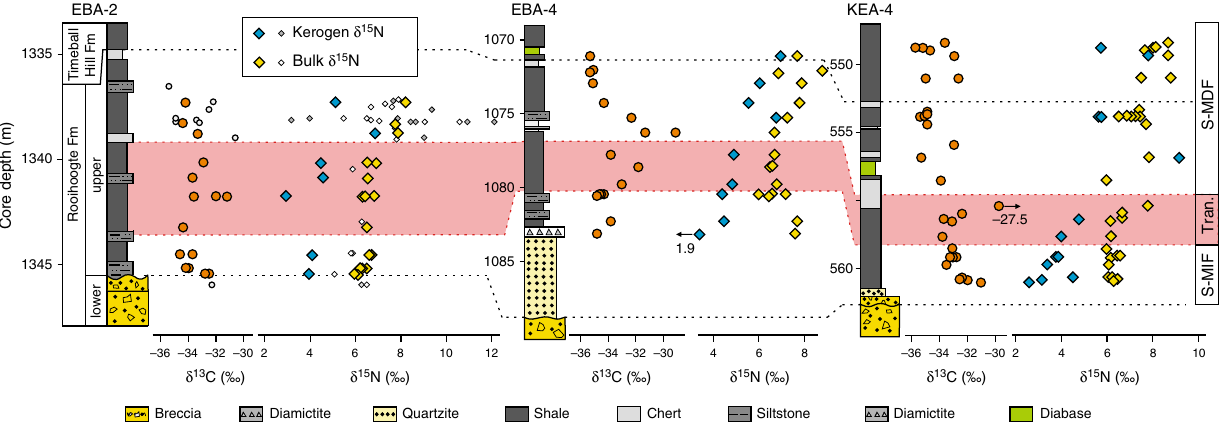
Fig. 2 Nitrogen and carbon isotope pro fi les spanning the upper Rooihoogte to lower Timeball Hill formations. Nitrogen and carbon isotopic data are reported relative to atmospheric N 2 and VPDB, respectively. The pink band represents the transitional interval (Tran.) from an anoxic atmosphere associated with sulphur mass-independent fractionation (S-MIF) to an oxygenated atmosphere associated with sulphur mass-dependent fractionation (S- MDF) 20 . The smaller symbols represent data from Zerkle et al. 14